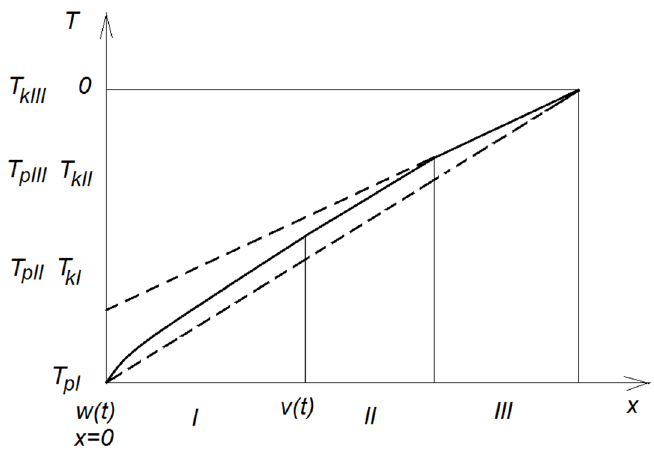
Figure 11. Temperature function on the sections w ( t ) ≤ x < v ( t ) and v ( t ) ≤ x < g caused by an impulse.